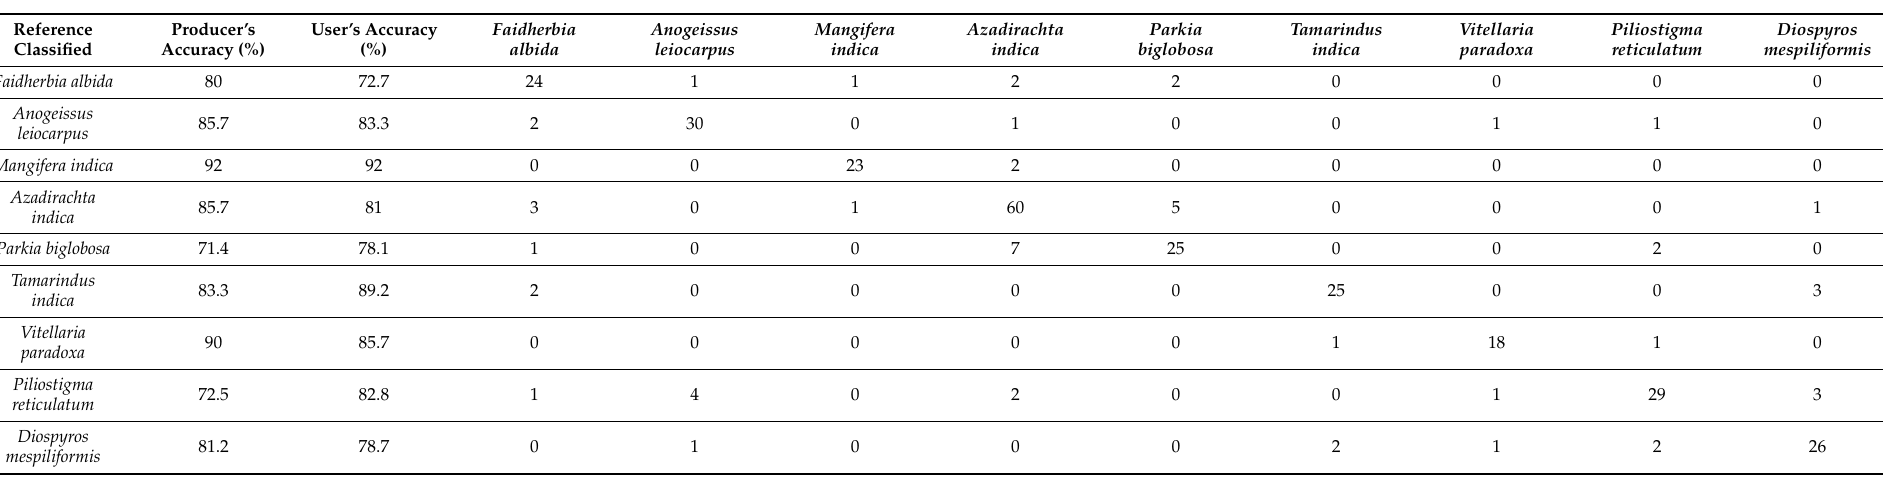
Table 6. Support Vector Machine (SVM)-based confusion matrix showing producer and user accuracy for nine dominant tree